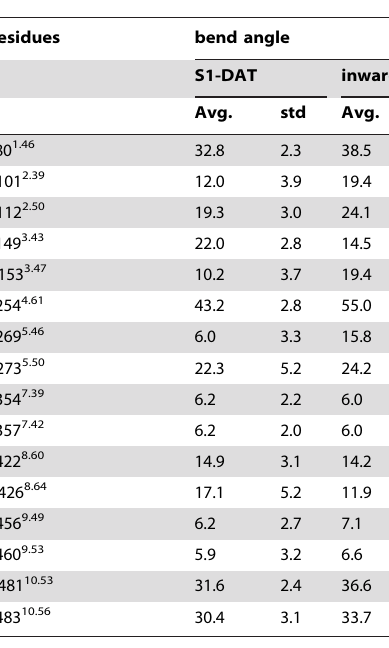
Table 5. ProKink analysis.